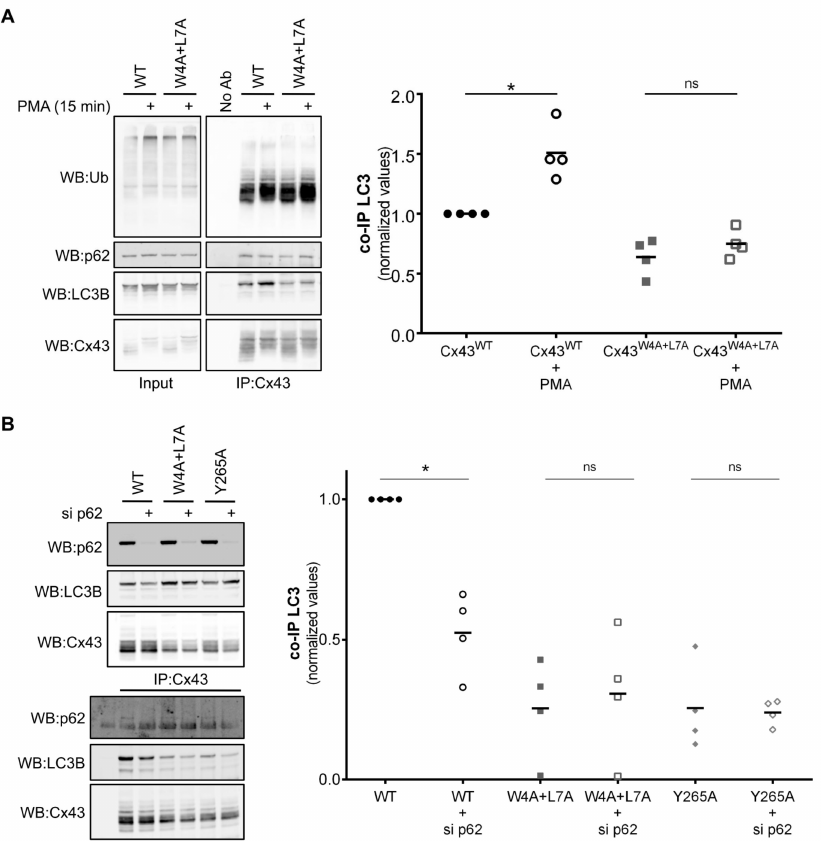
Figure 5. Role of phosphorylation and p62 in the binding of Cx43 to LC3B. ( A ) HEK293A cells co-transfected with GFP-LC3B and either wild type (WT) or mutant Cx43 (W4A + L7A) were incubated with 100 ng / mL PMA for 15 min. Cell lysates were then subjected to immunoprecipitation with goat polyclonal antibodies against Cx43, and the precipitates were analysed using Western blot using mouse monoclonal antibodies against ubiquitin, or rabbit polyclonal antibodies against Cx43, Nedd4 and LC3B. The level of co-immunoprecipitated LC3B with connexin in each condition was quantified, normalized to the immunoprecipitated connexin and plotted in a graph. * p < 0.05, ns: non-significant using the Mann-Whitney test. ( B ) HEK293A cells were co-transfected with GFP-LC3B, either wild type (WT) or mutant Cx43 (W4A + L7A), and with siRNA directed against p62. Cells were harvested after 24 h, the cell lysates were then subjected to immunoprecipitation with goat polyclonal antibodies against Cx43 and the precipitates were analysed using Western blot using mouse monoclonal antibodies against p62, or rabbit polyclonal antibodies against Cx43 and LC3B. The level of co-immunoprecipitated LC3B with connexin in each condition was quantified, normalized to the immunoprecipitated connexin and plotted in a graph. * p < 0.05, ns: non-significant using the Mann-Whitney